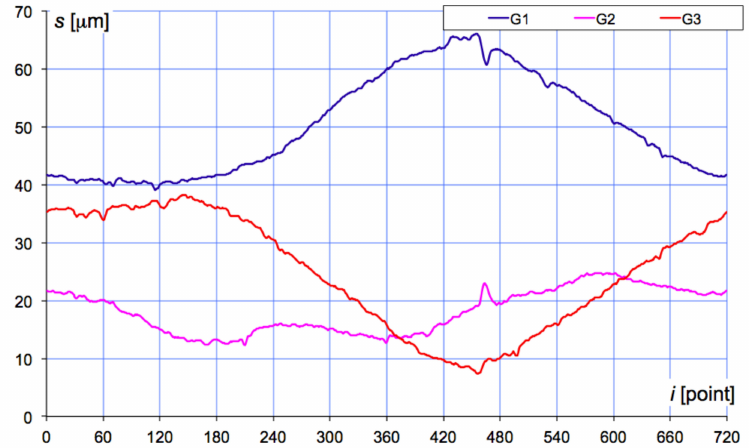
Figure 4. Displacement s registered by the air gauges G1, G2, and G3 during the 370 ◦ rotation of the gauging